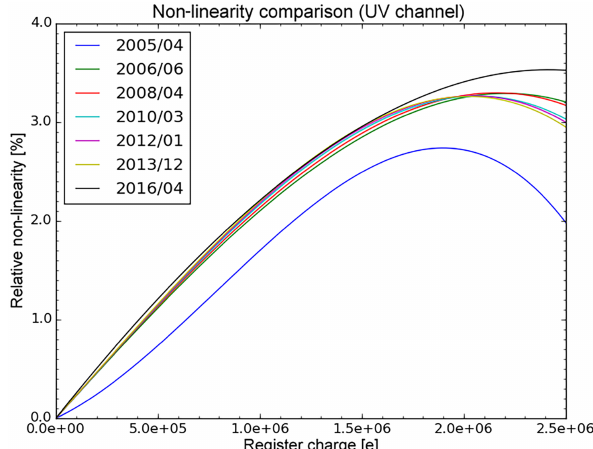
Figure 10. Non-linearity warnings in output of the CCD amplifiers over the mission time.